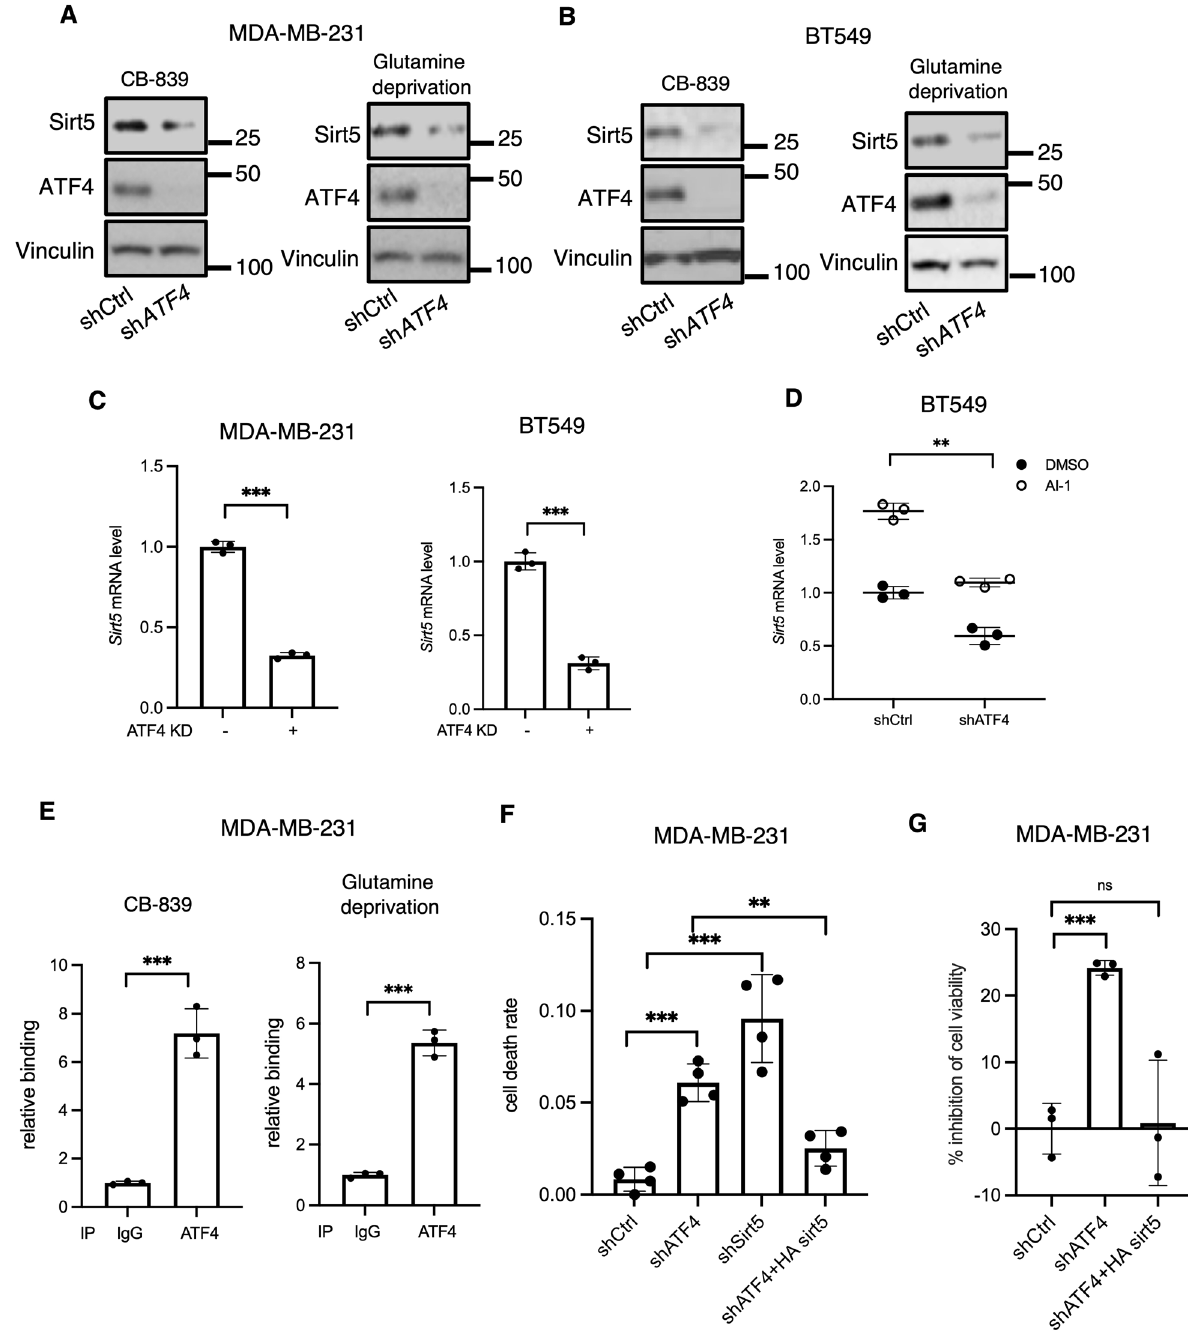
Fig. 6 Sirt5 is a transcriptional target of ATF4 necessary for survival. A Western blot analysis of WCL from control or ATF4 KD MDA-MB-231 cells treated with CB-839 (1 μ M) for 8 h or without glutamine for 24 h. Blots are representative of three independent experiments. B Western blot analysis of WCL from control or ATF4 KD BT549 cells treated with CB-839 (1 μ M) or without glutamine for 24 h. Blots are representative of two independent experiments. C RT-qPCR quanti fi cation of Sirt5 mRNA in control and ATF4 KD MDA-MB-231 and BT549 cells treated with CB- 839 (1 μ M) for 8 h (MDA-MB-231) or 24 h (BT549). Data shown are representative of two independent experiments and expressed as means ± SD for triplicate measurements. D RT-qPCR quanti fi cation of Sirt5 and ATF4 mRNA in control and ATF4 KD BT549 cells treated with CB- 839 (1 μ M) ± AI-1 (10 mM) for 24 h. Data shown are representative of two independent experiments and expressed as means ± SD for triplicate measurements. Differences were analyzed with two-way AVOVA. E ChIP analysis of ATF4 binding to the Sirt5 promoter in MDA-MB-231 cells treated CB-839 (1 μ M) or without glutamine (2% dialyzed FBS) for 8 h. Data shown are representative of two independent experiments and expressed as means ± SD for triplicate measurements. F The percentage of TUNEL positive cells ( n = 4). Data shown are representative of two independent experiments. G CCK8 assay showing the percent inhibition of cell viability for control, ATF4 knockdown and ATF4 knockdown cells with the ectopic expression of Sirt5. MDA-MB-231 cells were cultured in glutamine free medium for 48 h. Data shown are representative of two independent experiments and expressed as means ± SD for triplicate